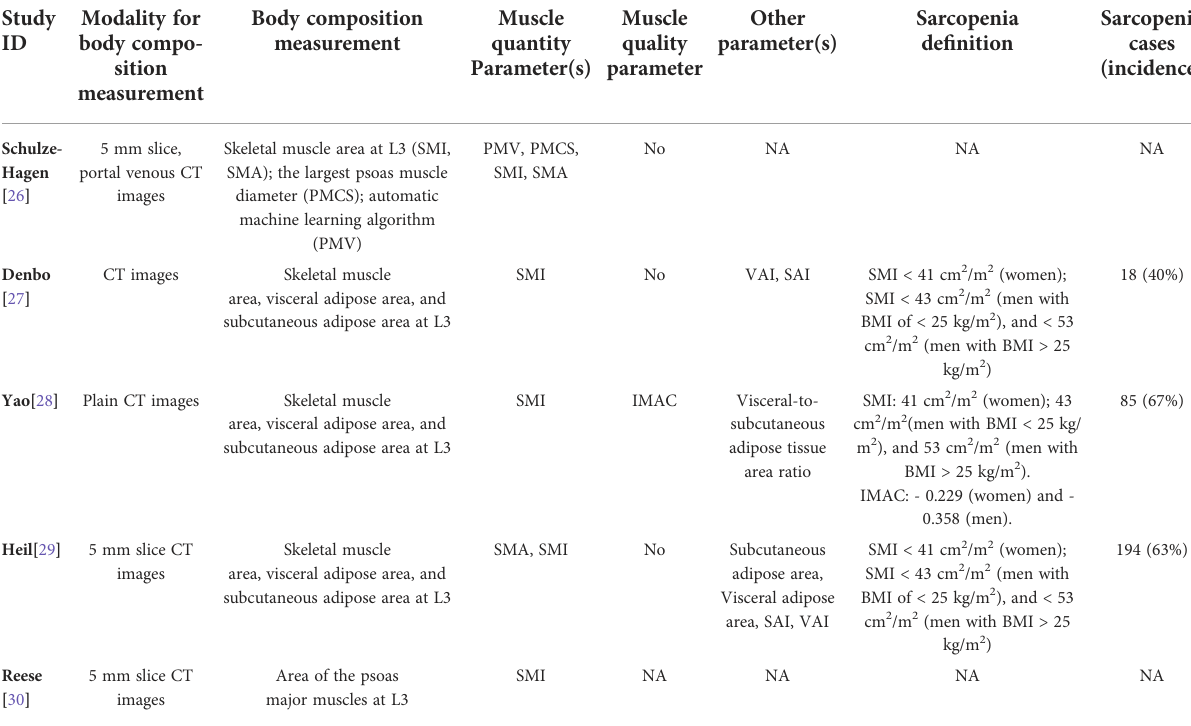
TABLE 2 Body composition measurement and sarcopenia de fi